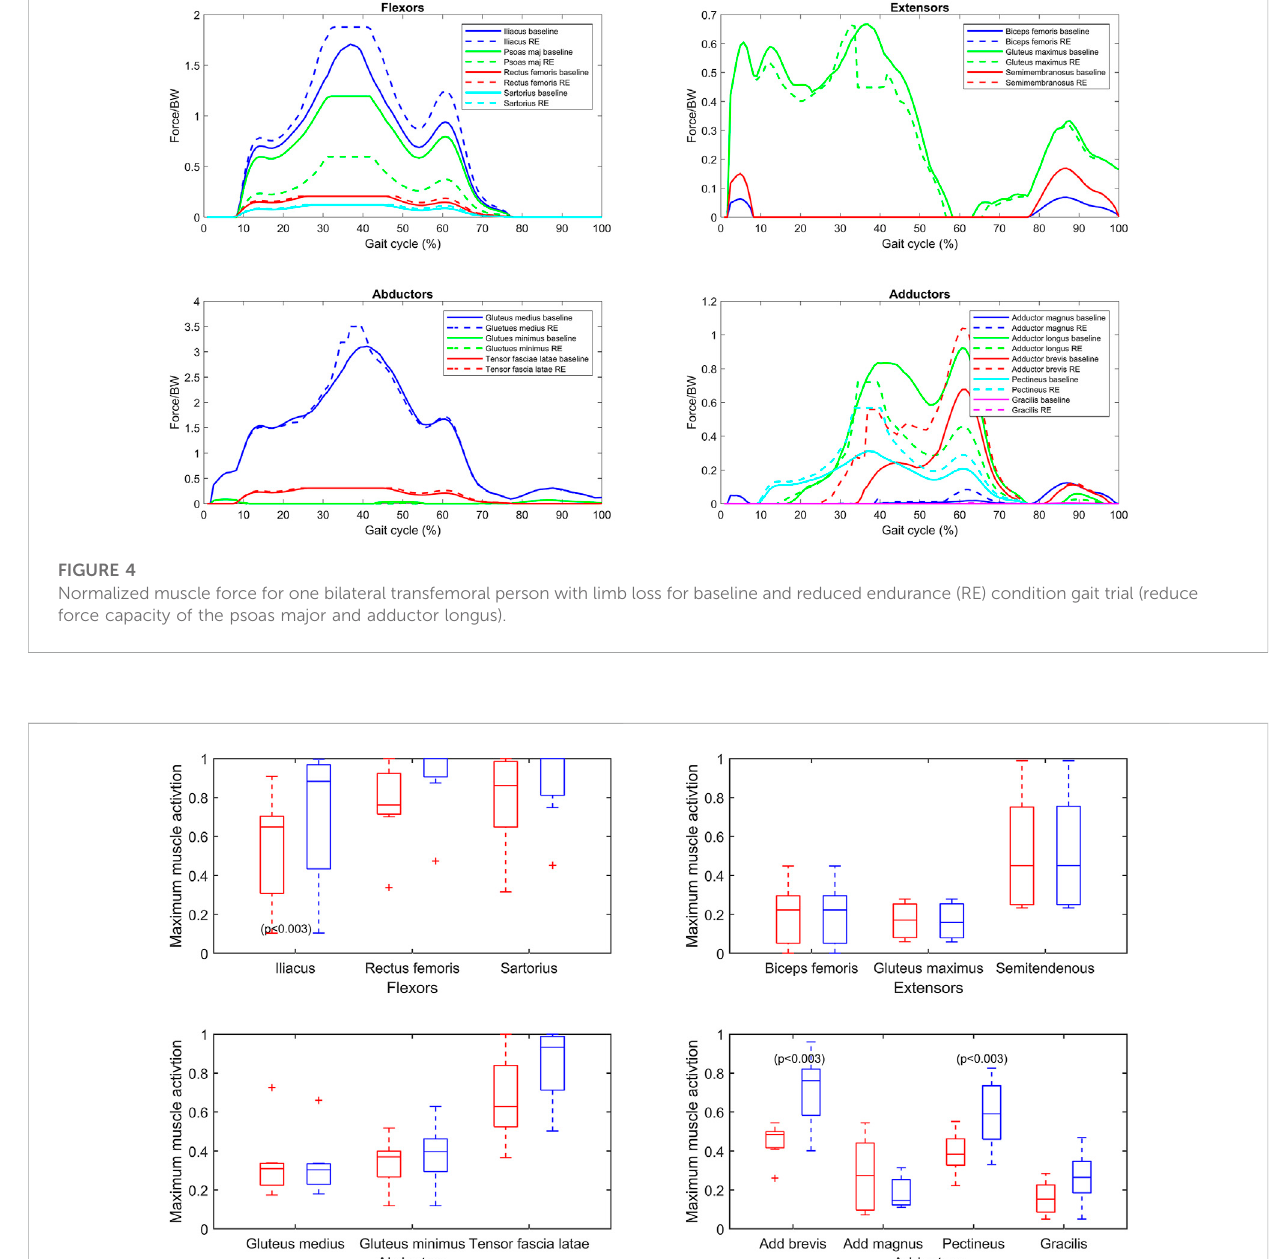
this plot for baseline and reduced endurance (2L, 2R, 3L, 3R, 4L, 4R, and 6R). All legs where a full solution could not be found were excluded (1L, 1R, 5L, 5R, and 6L). The maximum activations (force normalized to F i max ) are plotted for the baseline (red) and the reduced endurance (blue) simulations. In the simulations of reduced muscular endurance of the psoas major and adductor